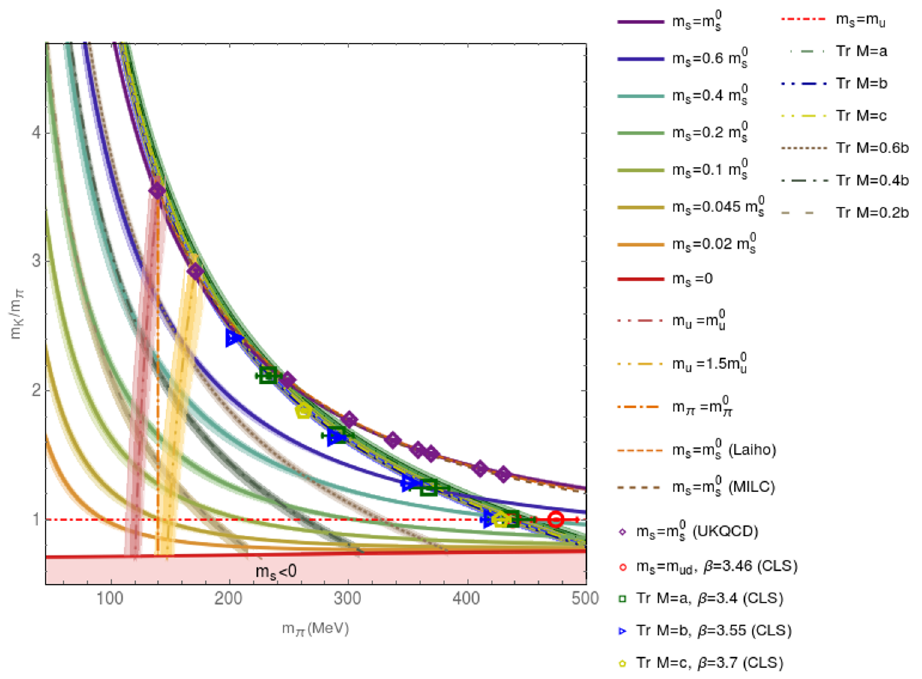
Figure 12 . Chiral trajectories ( m K =m (cid:25) ratio) considered in Fit IV in comparison with lattice data.